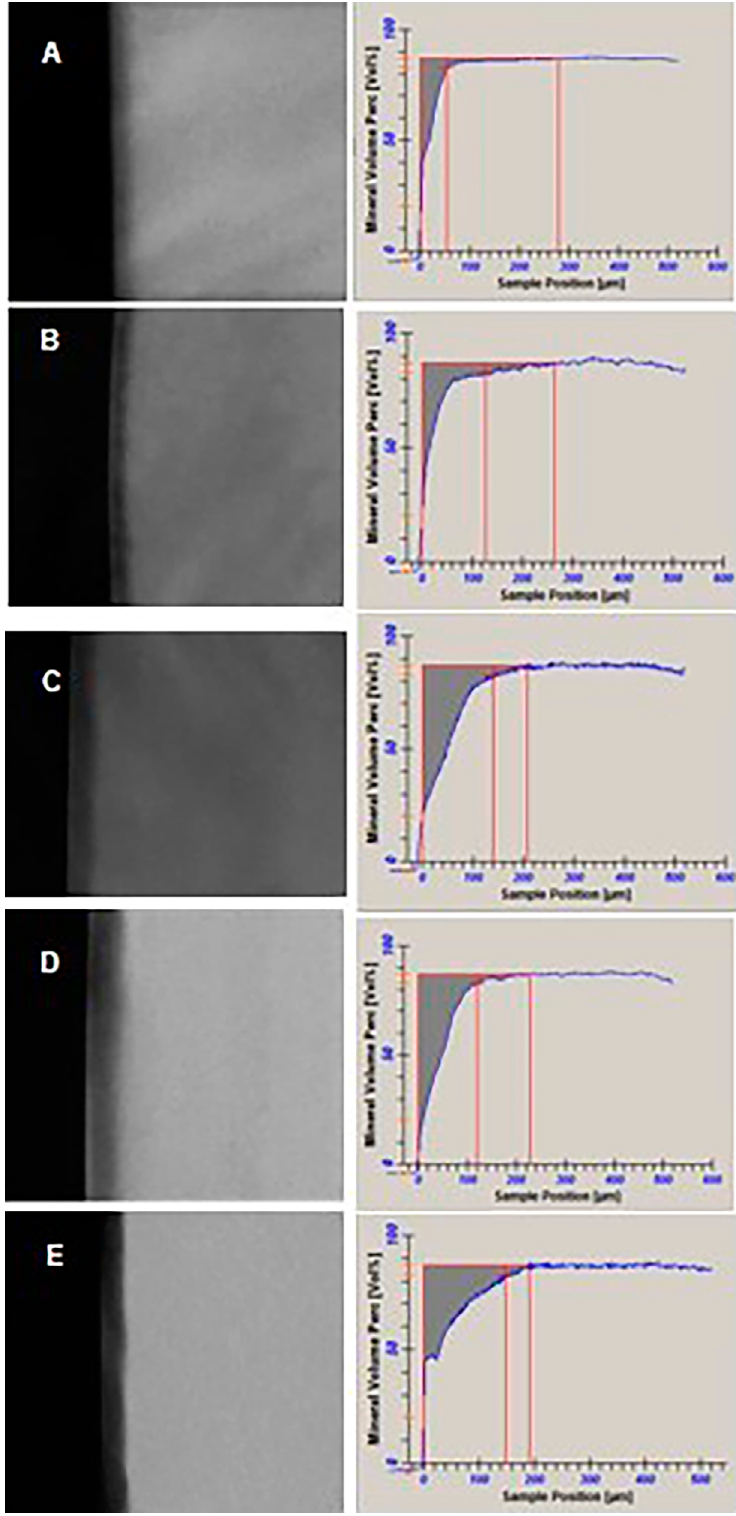
Figure 2- Representative TMR profile of the WSLs produced on enamel under microcosm biofilm for 2 (A), 4 (B), 6 (C), 8 (D) and 10 (E) days.